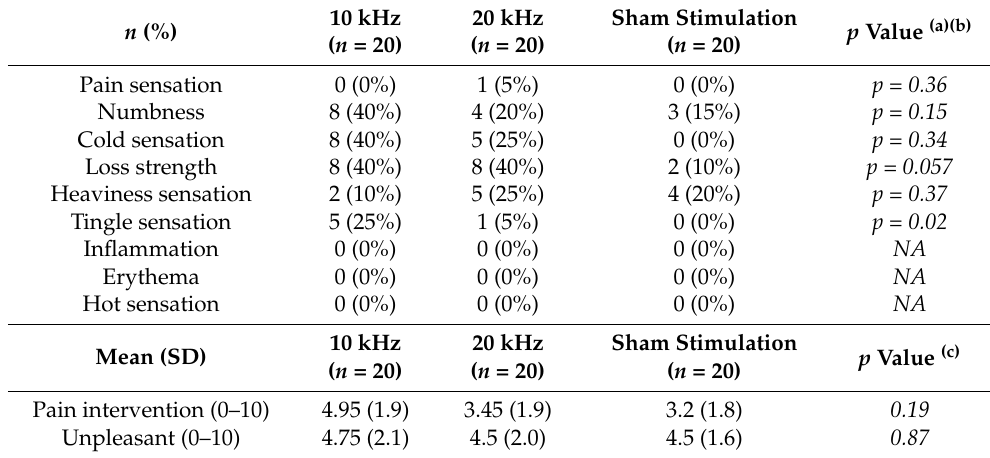
Table 4. Subjective measure. Statistical test: (a) Pearson’s chi-squared test, (b) Fisher’s exact test, (c) One-way analysis of variance (one-way ANOVA).